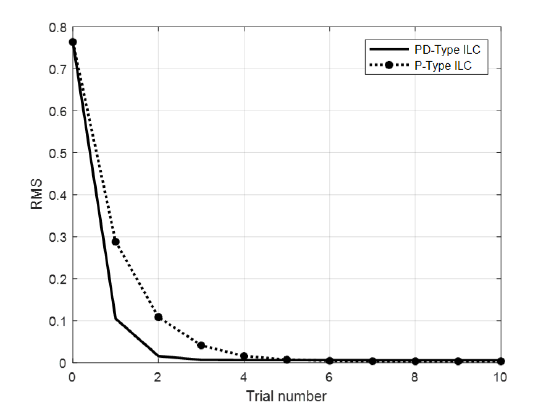
Figure 5. Curve of RMS of polyhedron uncertain system with the number of